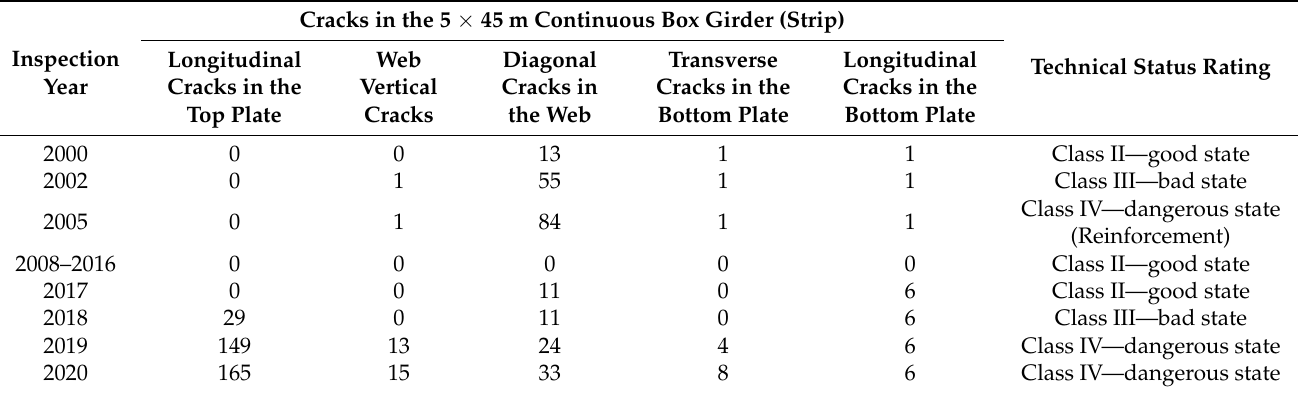
Table 1. The crack development process of the bridge.